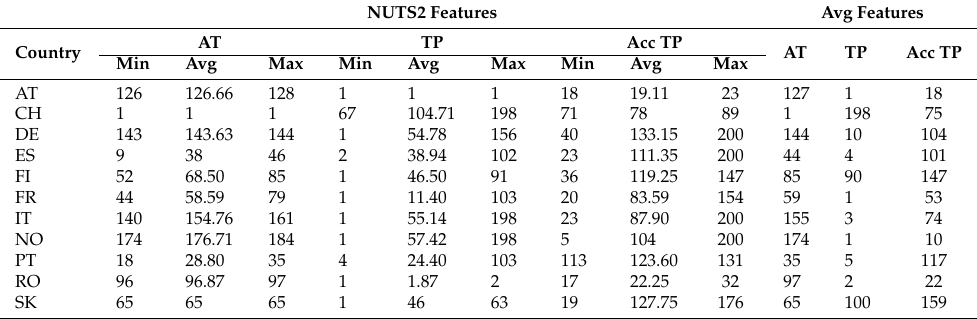
Table A1. Optimal lags (in day) used in the ML